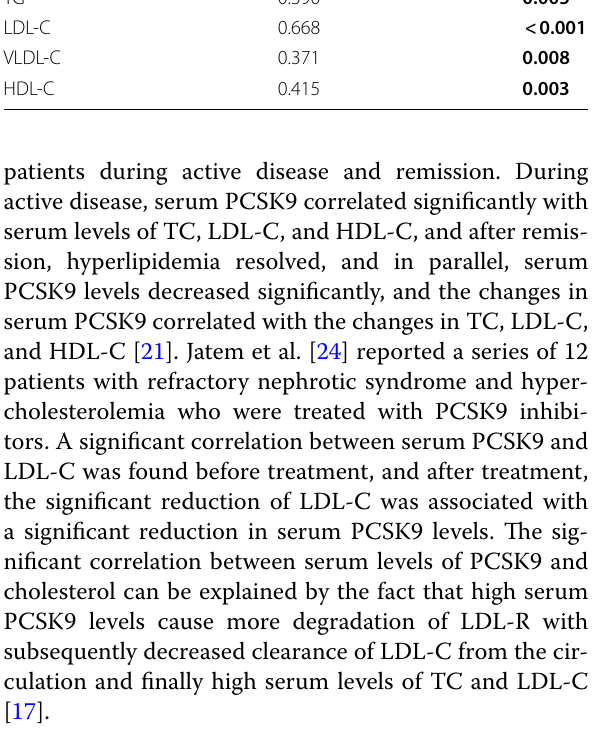
Table 4 Multivariable linear regression analysis with serum PCSK9 levels as the dependent variable